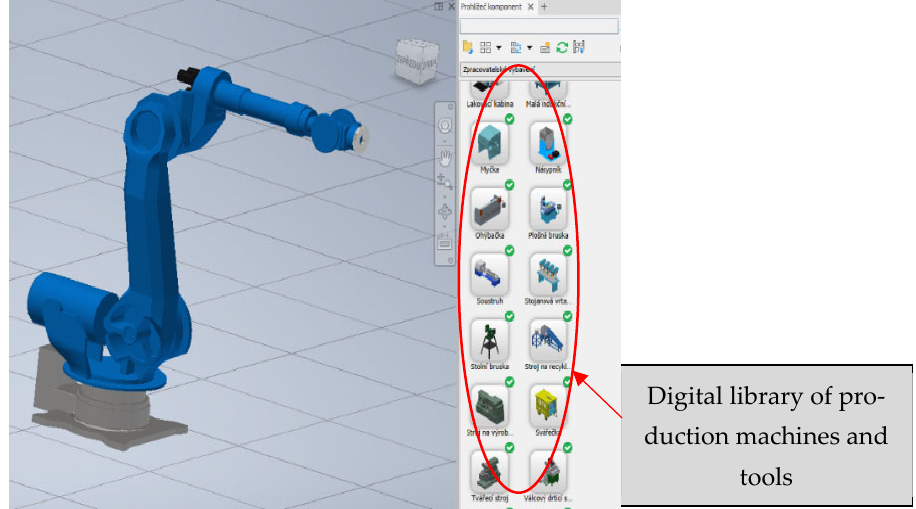
Figure 7. Visualization of a digital library of production equipment.